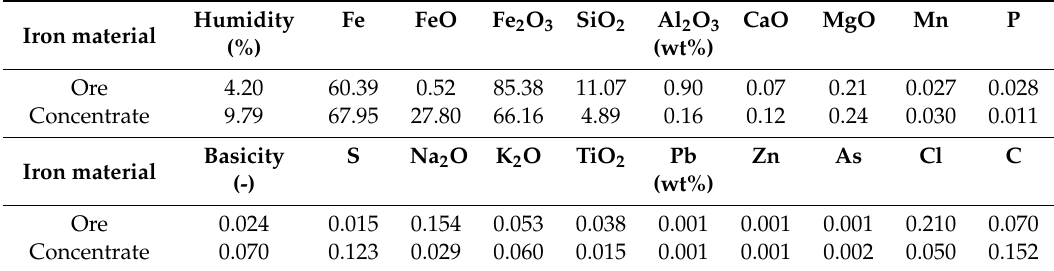
Table 2. Chemical analysis of Fe materials [12].